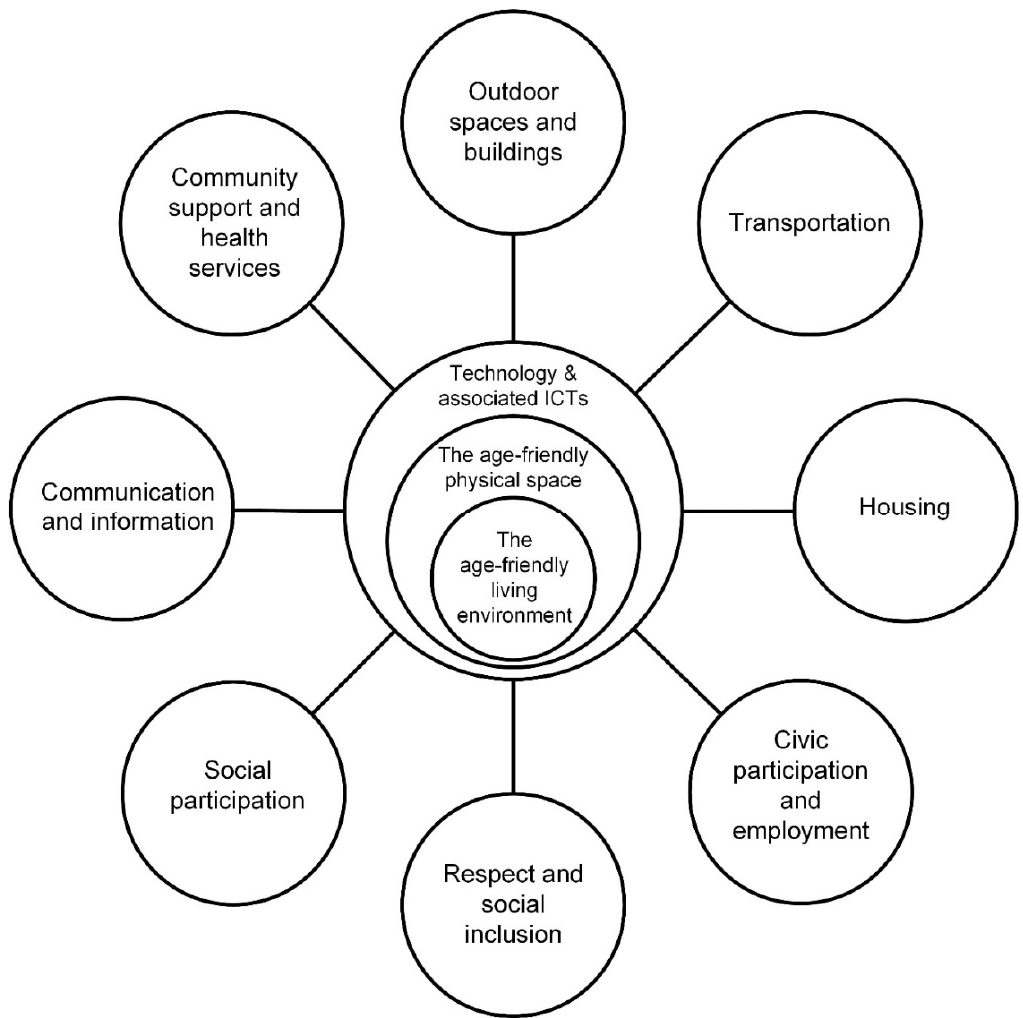
Figure 4. Smart age-friendly ecosystem framework (SAfE) [30].